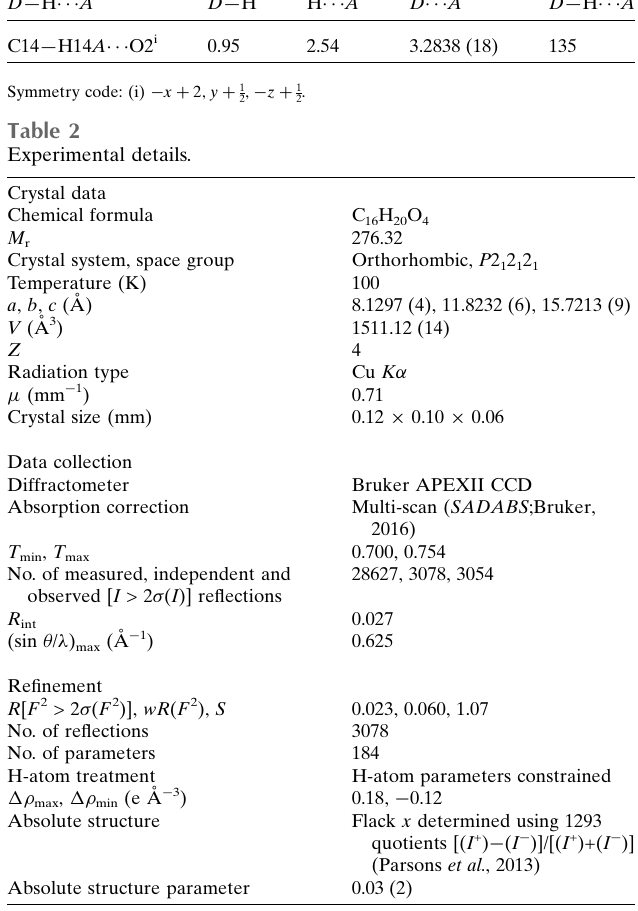
Table 1 Hydrogen-bond geometry (A˚ , (cid:4) ).